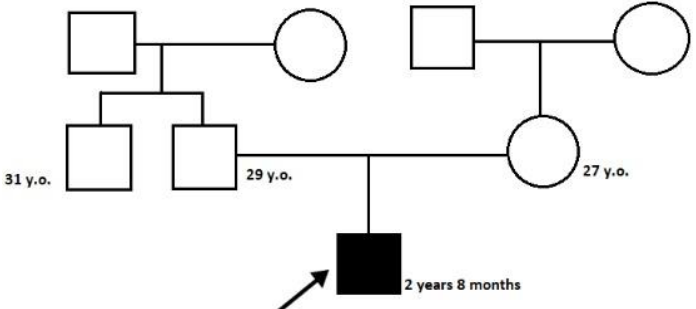
Figure 3. The pedigree of the proband.